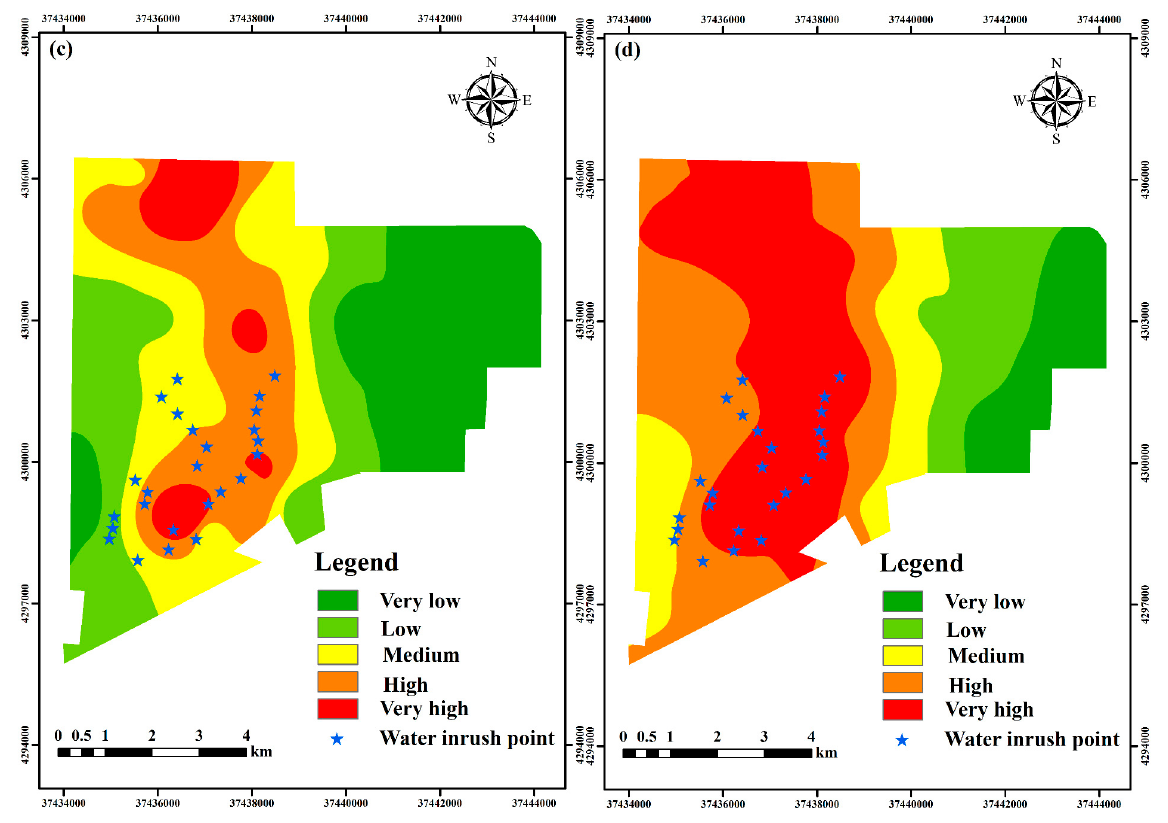
Figure 11. Verification diagram of the roof water inrush risk evaluation results under different risk-coping attitudes: ( a ) a = 0.1; ( b ) a = 0.5; ( c ) a = 0.7; ( d ) a = 0.9.